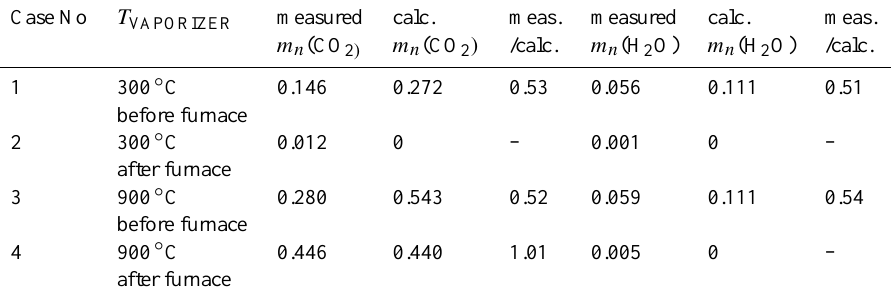
Table 3. Measured and calculated normalized mass m n (CO 2 ) and m n (H 2 O). Case No T VAPORIZER measured calc. meas. measured calc. meas. m n (CO 2 ) m n (CO 2 ) /calc. m n (H 2 O) m n (H 2 O) /calc. 300 ◦ C 0.146